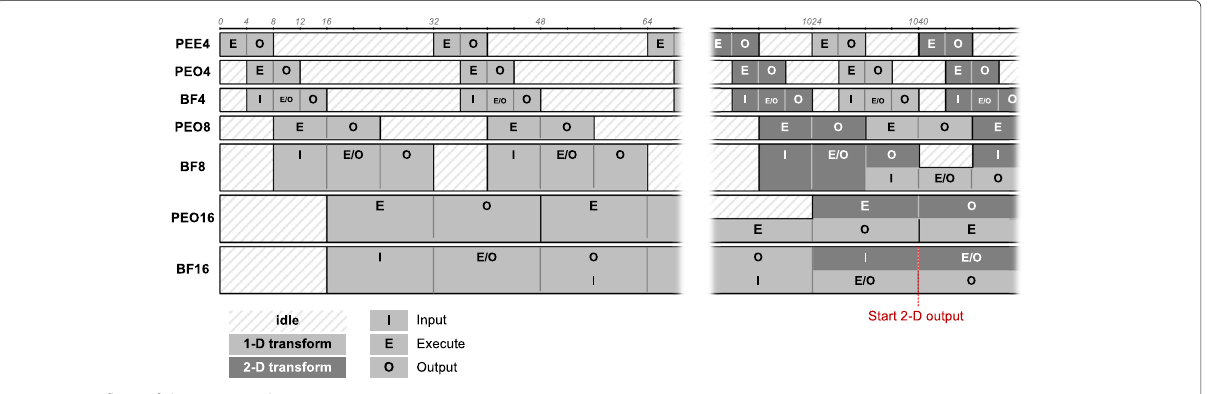
Fig. 7 Data flow of the proposed IDCT circuit